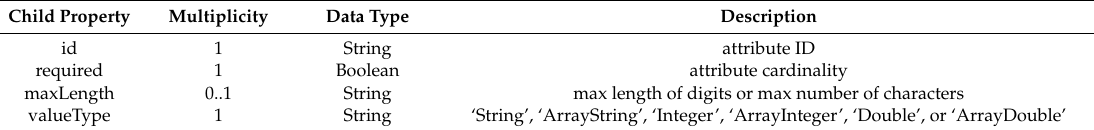
Table 3. Definition of ObjectKey data